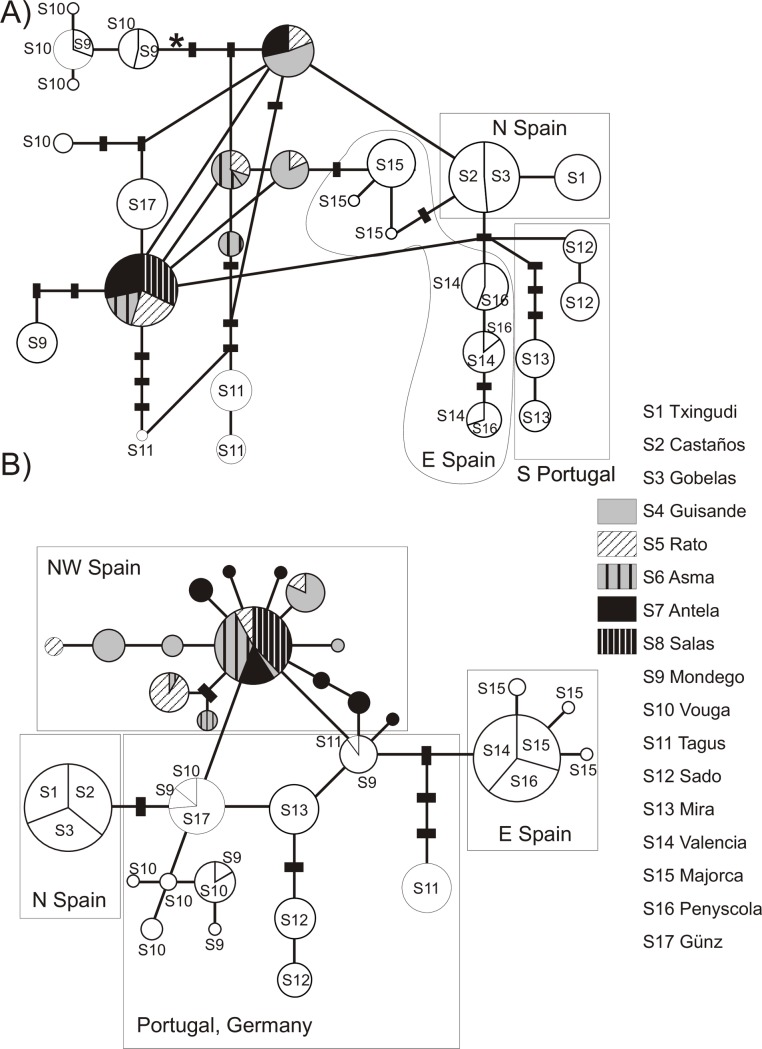
Statistical parsimony networks showing abundance and occurrence of each haplotype of G. aculeatus sampled in Portugal, Spain and Germany (localities S1-S17) as revealed by (A) 409 bp of the control region and (B) 755 bp of the cytochrome b. Circle size reflects the frequency of haplotype (cr: maximum = 53, minimum = 1; cytb: maximum = 55, minimum = 1). Solid lines connecting haplotypes represent a single mutational event, regardless of their length. Black rectangles represent missing or theoretical haplotypes. The connection limits for these statistical parsimony networks (95%) were eight for cr and eleven for cytb. The asterisk in (A) marks the only gap in the alignment. Network (A) was calculated using 346 sequences, whereas network (B) was based on 311 sequences showing no ambiguous characters.